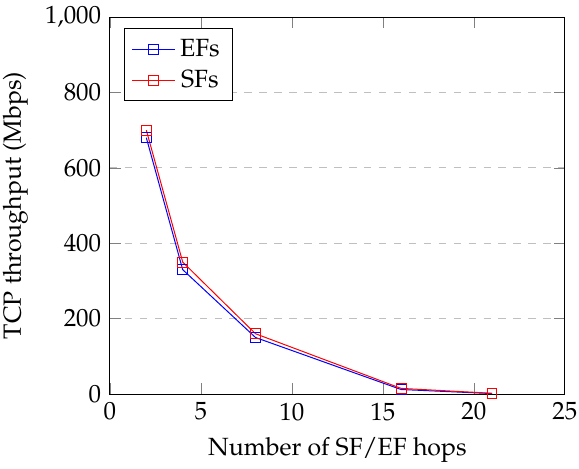
Figure 9. TCP throughput per SF/EF